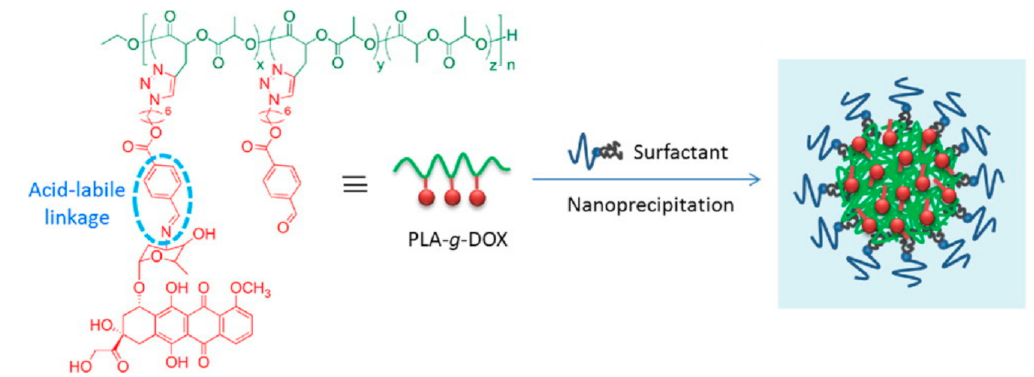
Figure 4. High drug loading and pH-responsivity PLA- g -doxorubicin (DOX) nanoparticles [99]. Reprinted from Cheng with permission from Express Polymer